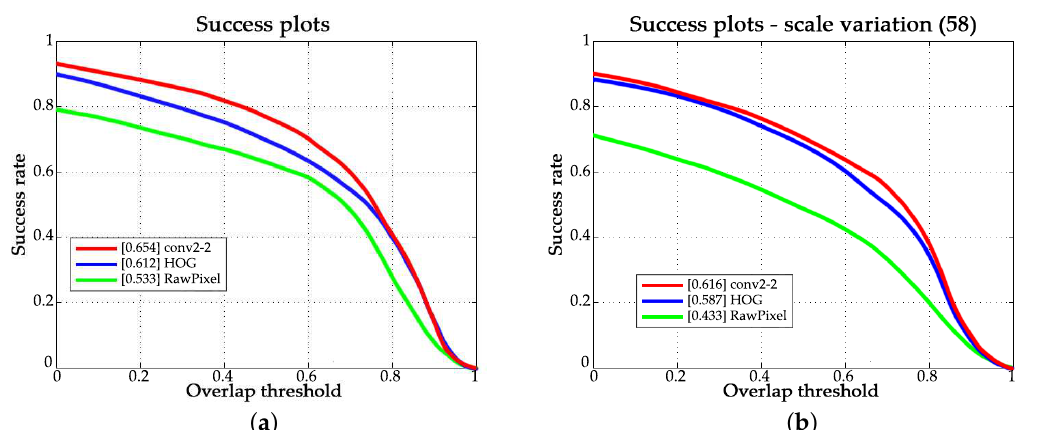
Figure 9. Scale estimation performance using different features. ( a ) Success plots on OTB-2015; ( b ) Success plots over sequences with the attribute of scale